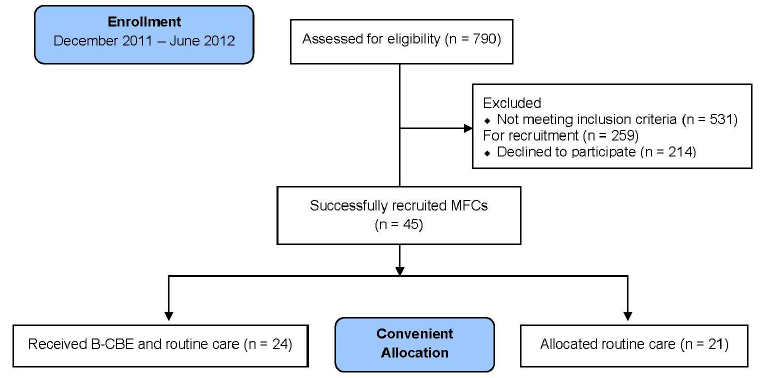
Figure 1. Flow diagram of recruitment.